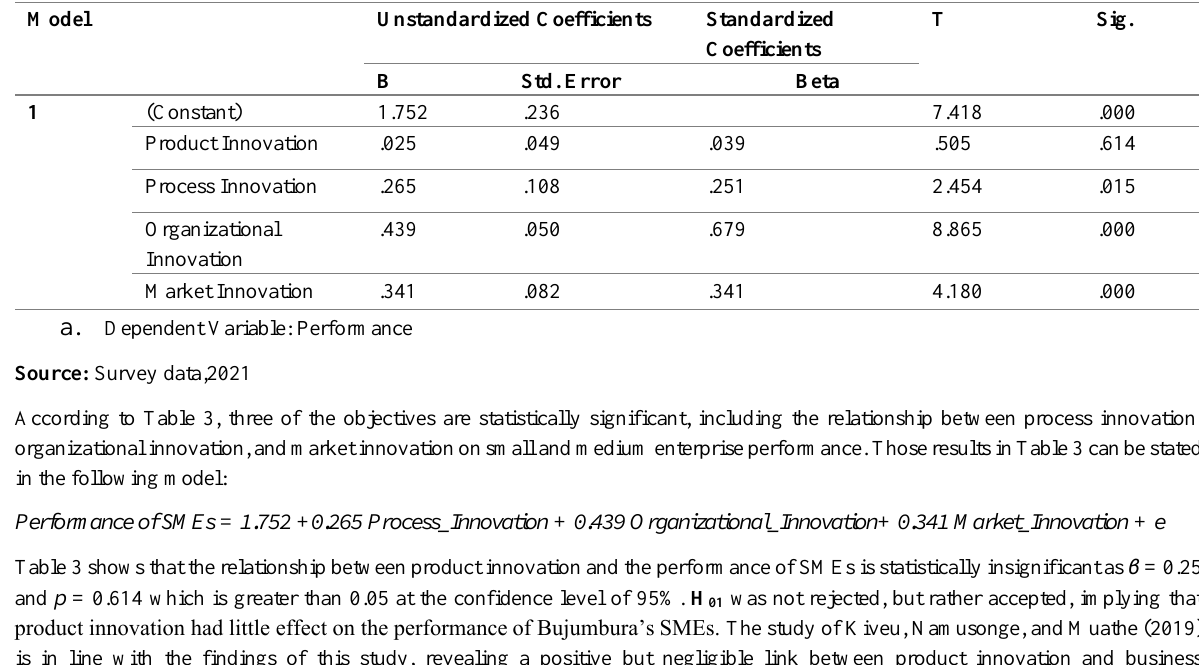
Table 2 results show a p-value =0.000 that is less than 0.05 and F (4,127) = 36.104, which means a significant effect of entrepreneurial innovation (product innovation, process innovation organizational innovation, market innovation) on the performance of SMEs. Table 3: Regression